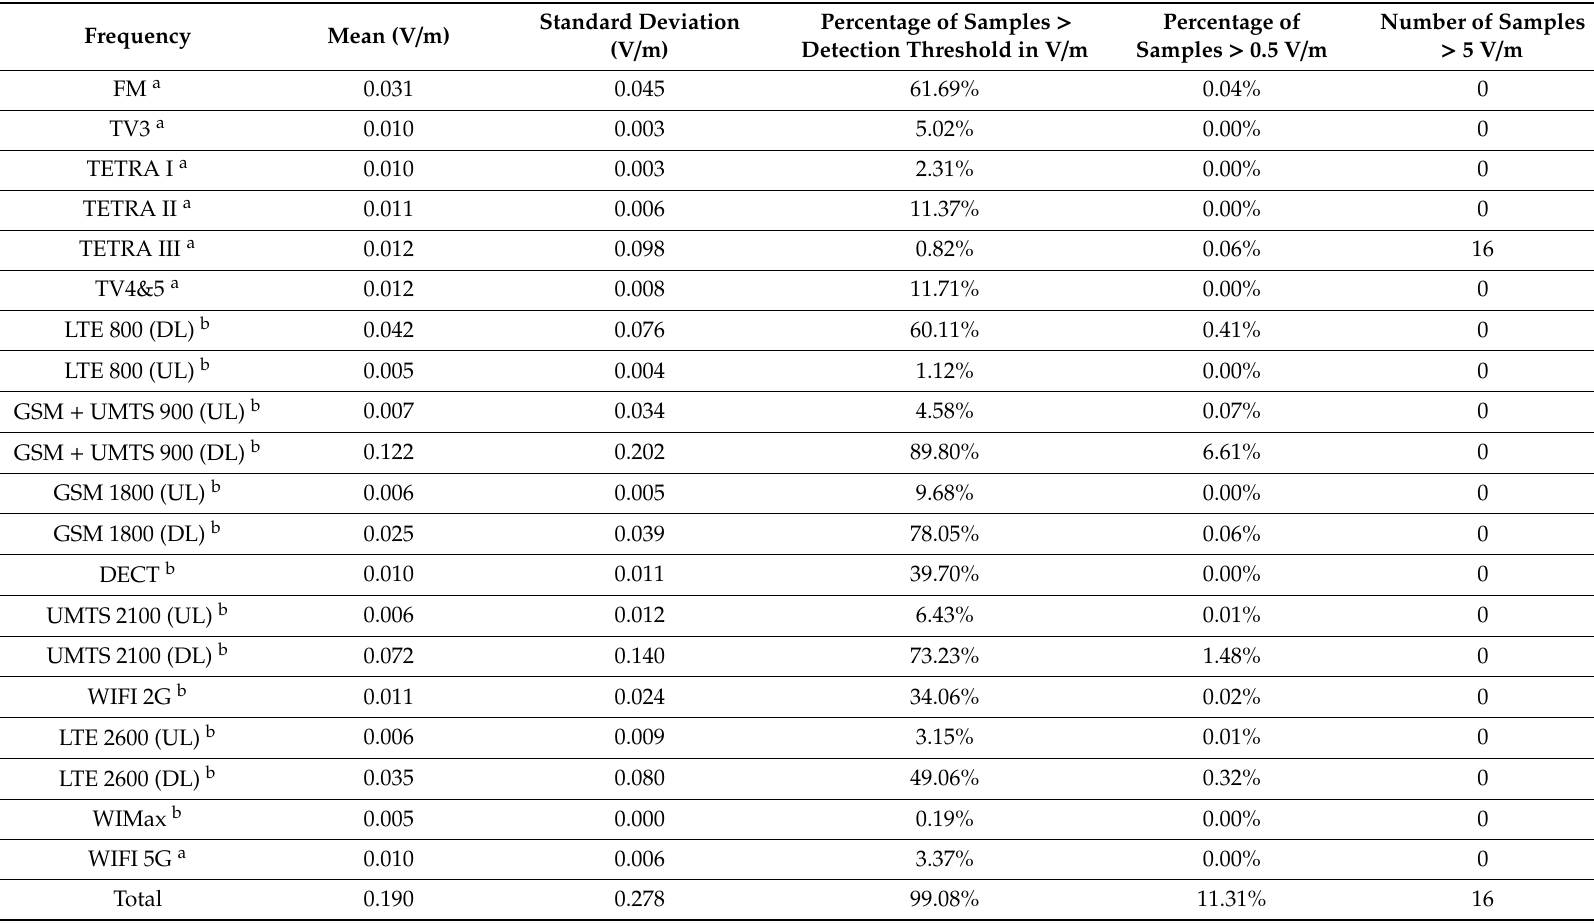
Table 2. Results of 78,858 measurements per frequency (every eight seconds) during all the working time of all employees at all